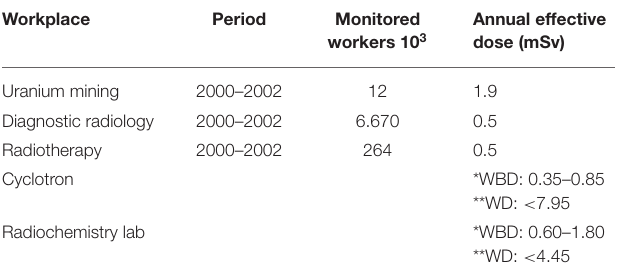
TABLE 1 | Occupational exposures for various job categories. Workplace